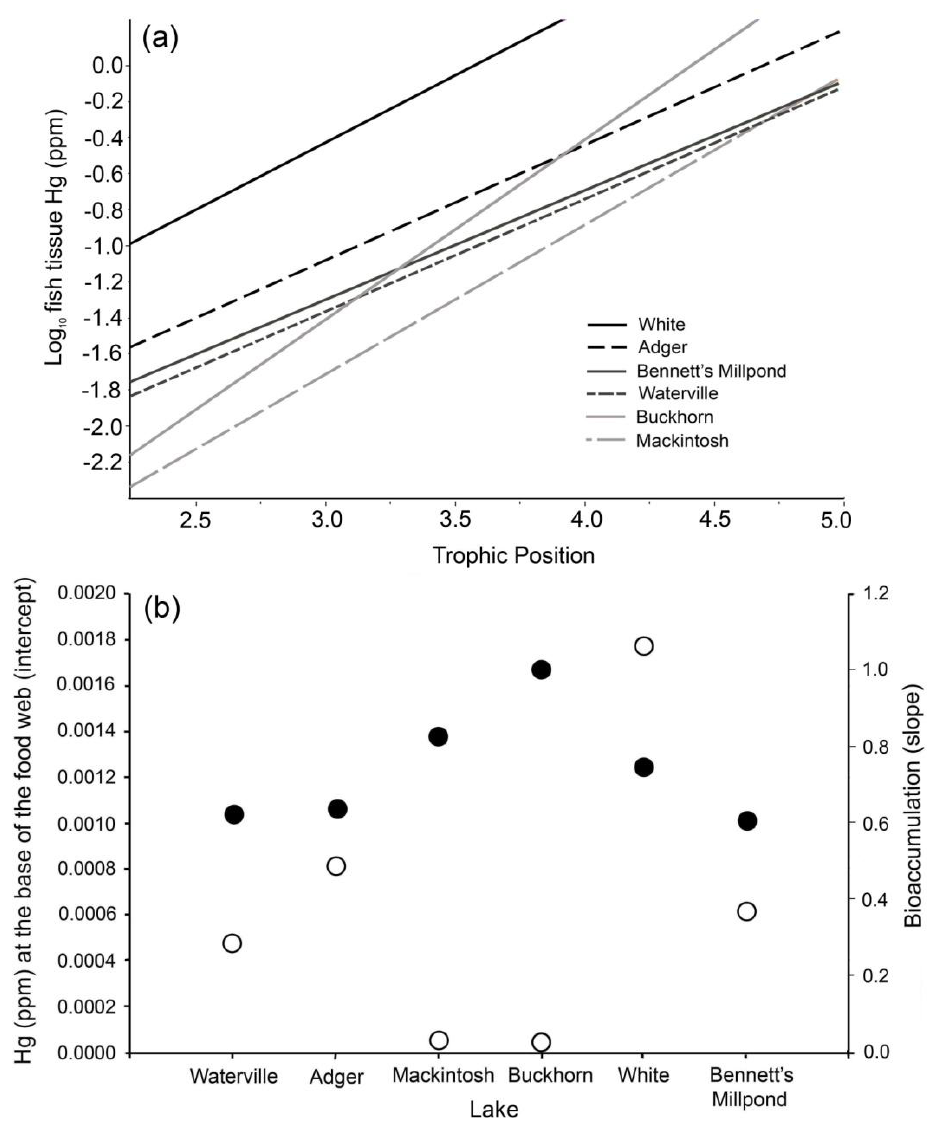
Figure 3. ( a ) Regression relationships for fish tissue Hg and trophic level (as measured by nitrogen isotopes) in each of six study lakes in North Carolina, USA, using largemouth bass and bluegill data. ( b ) Level of mercury at the base of the food web (y-intercept; open circles) and rate of bioaccumulation (slope; dark circles) in each study lake [20,49], determined using the regressions in ( a